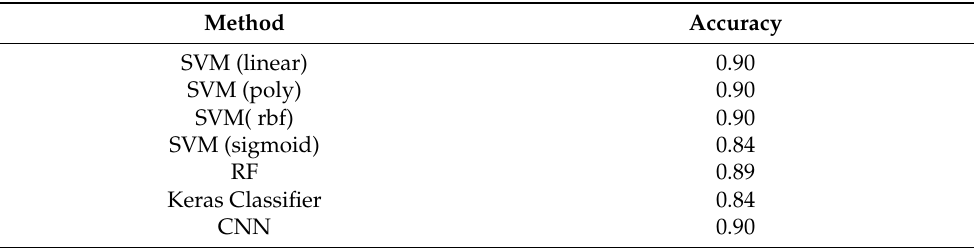
Table 6. Accuracy